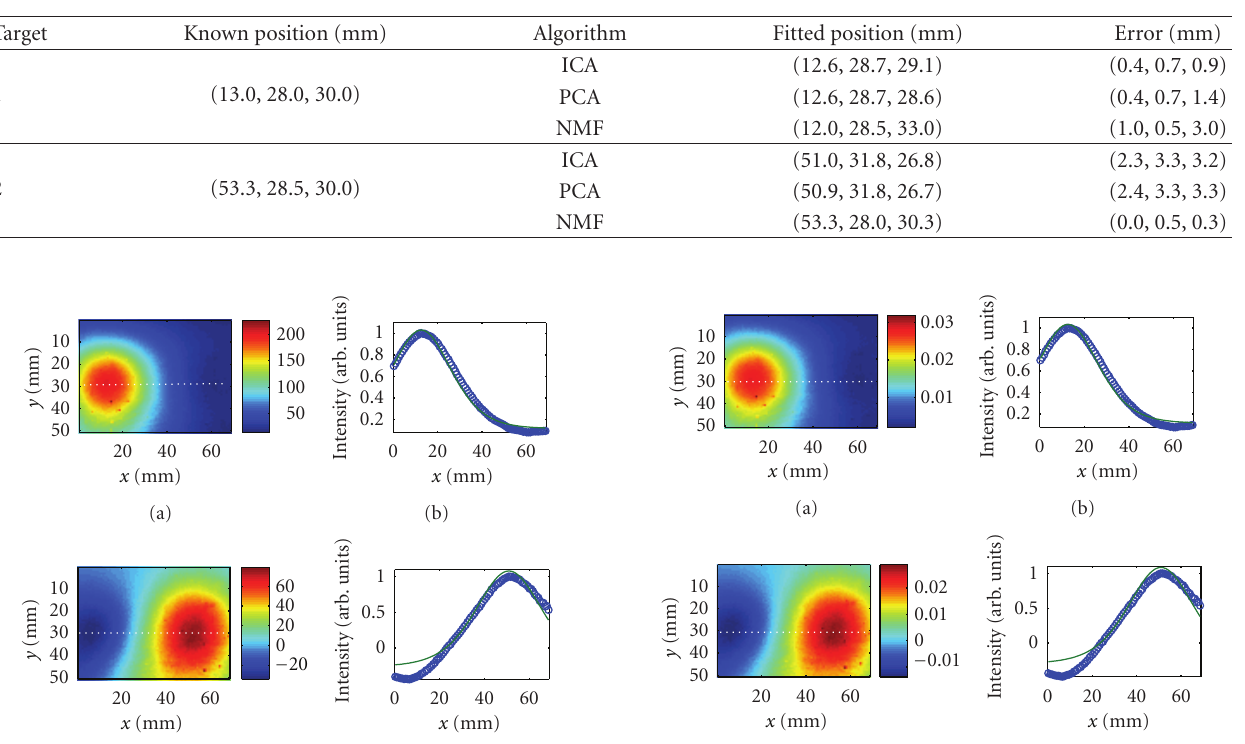
Table 3: Known positions versus retrieved positions of the scattering targets using ICA, PCA, and NMF algorithms.